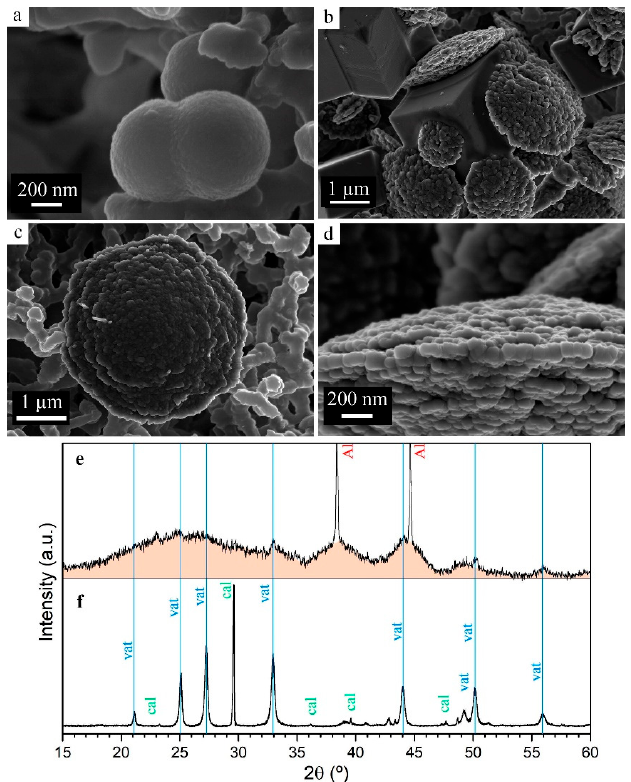
Figure 5. Representative field emission-scanning electron microscope FE-SEM images showing ( a ) spherical amorphous calcium carbonate (ACC) nanoparticles consistent in size with dynamic light scattering (DLS) measurements; ( b ) coupling of vaterite dissolution and rhombohedral calcite growth; ( c ) vaterite showing an almost perfect hexagonal plate shape; ( d ) detail of a vaterite crystal surface showing a nanogranular structure; ( e ) x-ray diffraction (XRD) analysis of precipitates obtained during titration experiments at the early stages of nucleation; and ( f ) representative diffraction pattern of samples collected at the very end of the titration experiments. Legend: cal: calcite, vat: vaterite, Al: aluminum sample holder (used as internal standard). The orange shaded area in ( e ) indicates the characteristic region of amorphous calcium carbonate (see Figure S2 for additional FE-SEM images showing the transformation of vaterite into calcite via a dissolution-precipitation process).